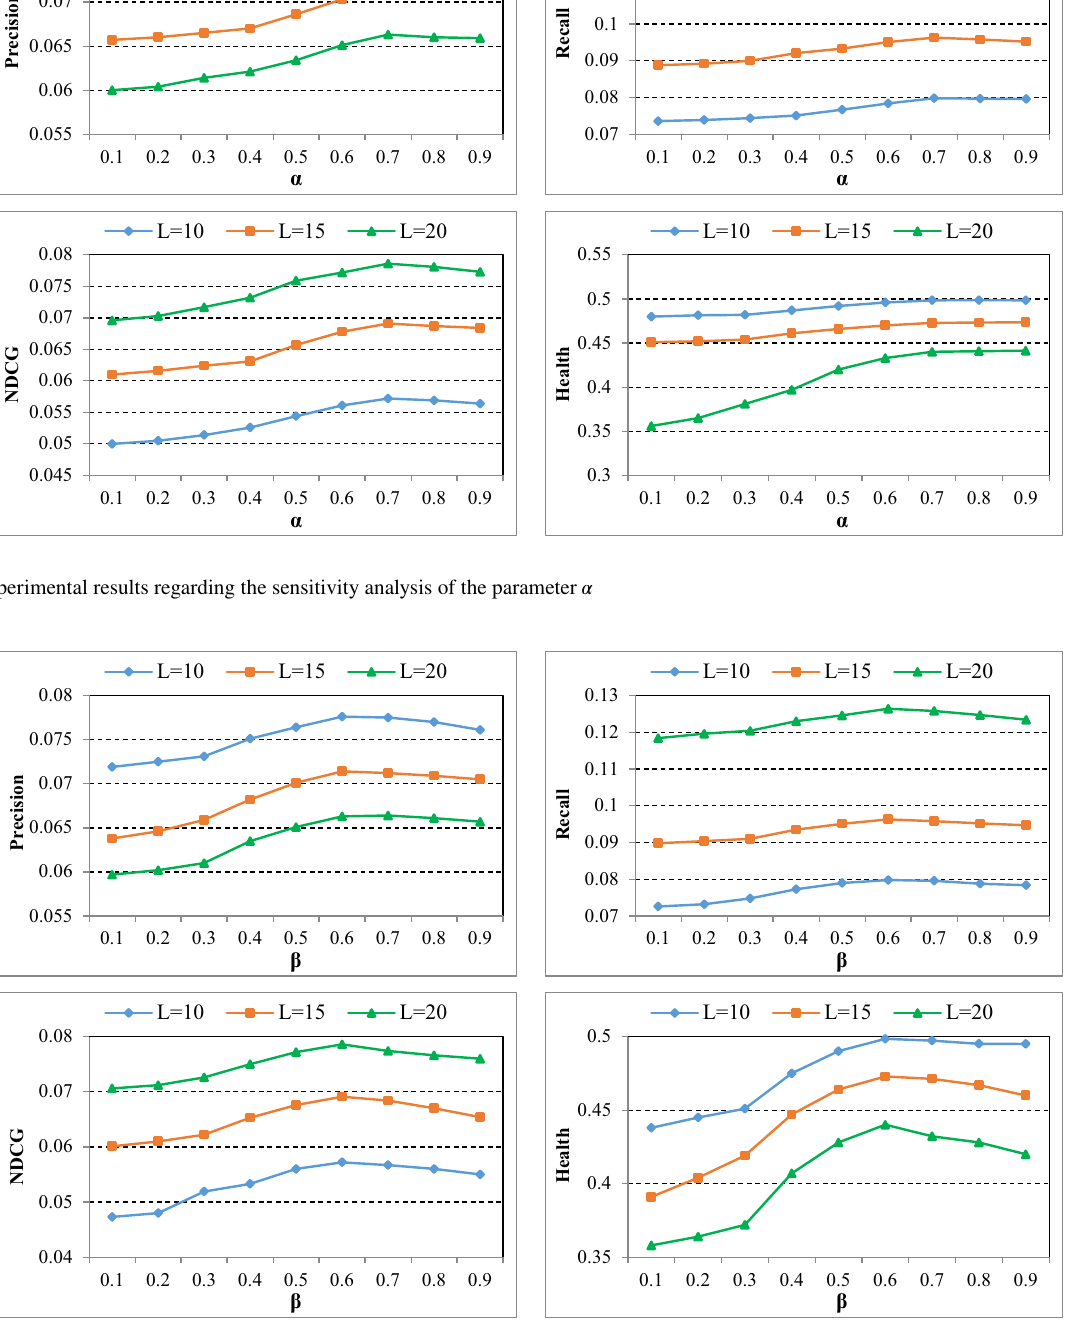
Fig. 5 Experimental results regarding the sensitivity analysis of the parameter